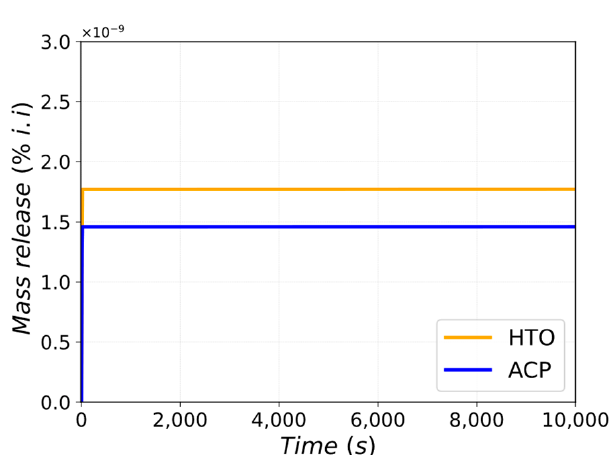
Figure 27. Direct unfiltered release of HTO and ACP (%i.i).